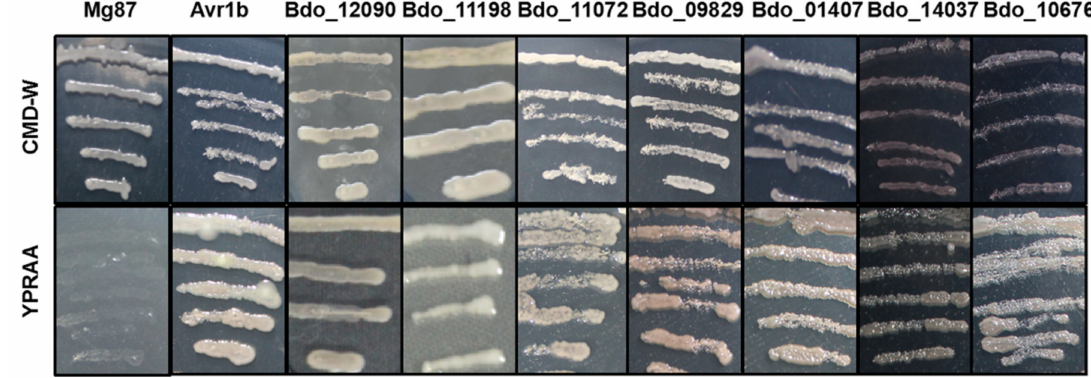
Figure 3. Functional validation of signal peptides of candidate effectors from B. dothidea using a yeast invertase secretion assay. The transformed yeast strains of YTK12 were able to grow on YPRAA media with raffinose as sole carbon source. The N-terminal sequences of Magnaporthe oryzae Mg87 and Phytophthora sojae Avr1b were used as negative and positive controls,